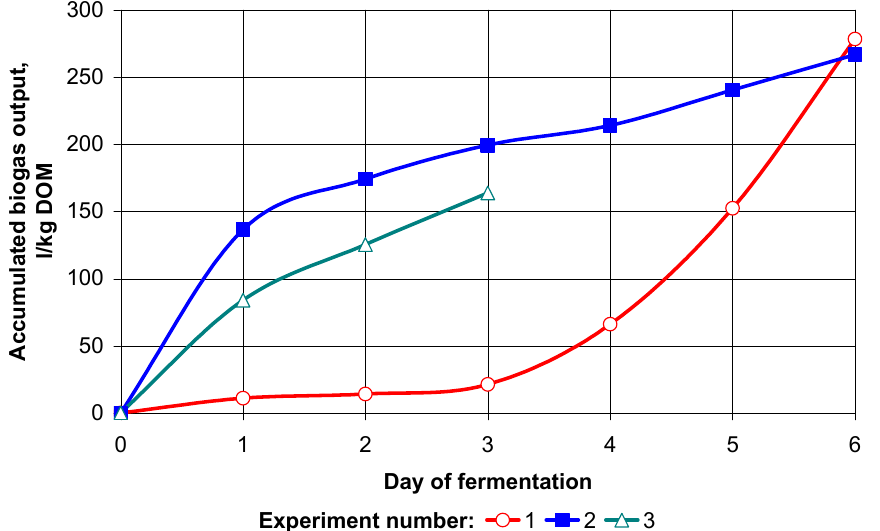
Figure 3. Accumulated biogas output in the mono-fermentation of the molasses broth at a fermen- tation temperature of 40 °C: 1 − 20 l of broth was added to 10 l of biosludge, pH = 4.7; 2 − 8.5 l of vinasse, pH = 6.7 was added to 17.5 L of biosludge; 3 − 20 l of substrate, contains of 3 l of vinasse and 17 l of water, pH = 6.3, was added to 10 l of biosludge.